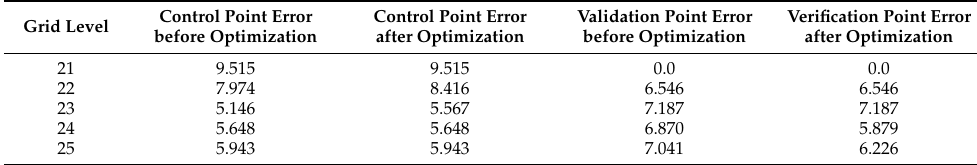
Table 5. Calculation results of grid errors in scene A (unit: m). Grid Level